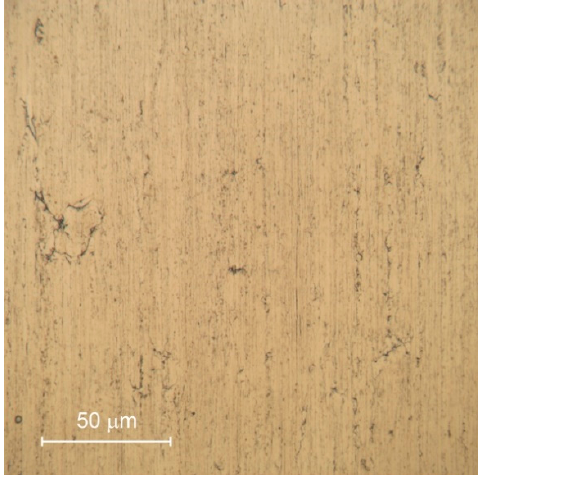
Figure 1. Pictures of two representative AISI 430 ferritic stainless steel samples with different visual appearances: with a mirror-like finish ( a ) and with a presence of haze ( b ). Pictures were taken with a 100× magnification objective, and the field of view was 184.2 μ m × 184.2 μ m.